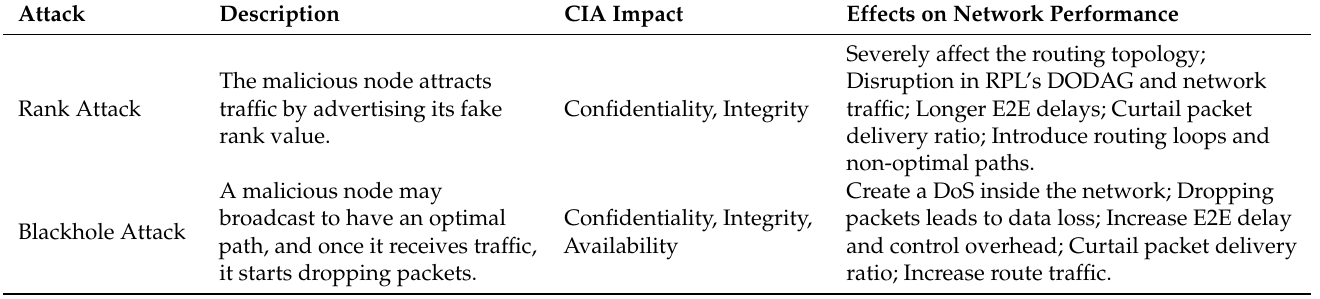
Table 1. Description of Attacks Under Consideration for Proposed Secure Routing Protocol.